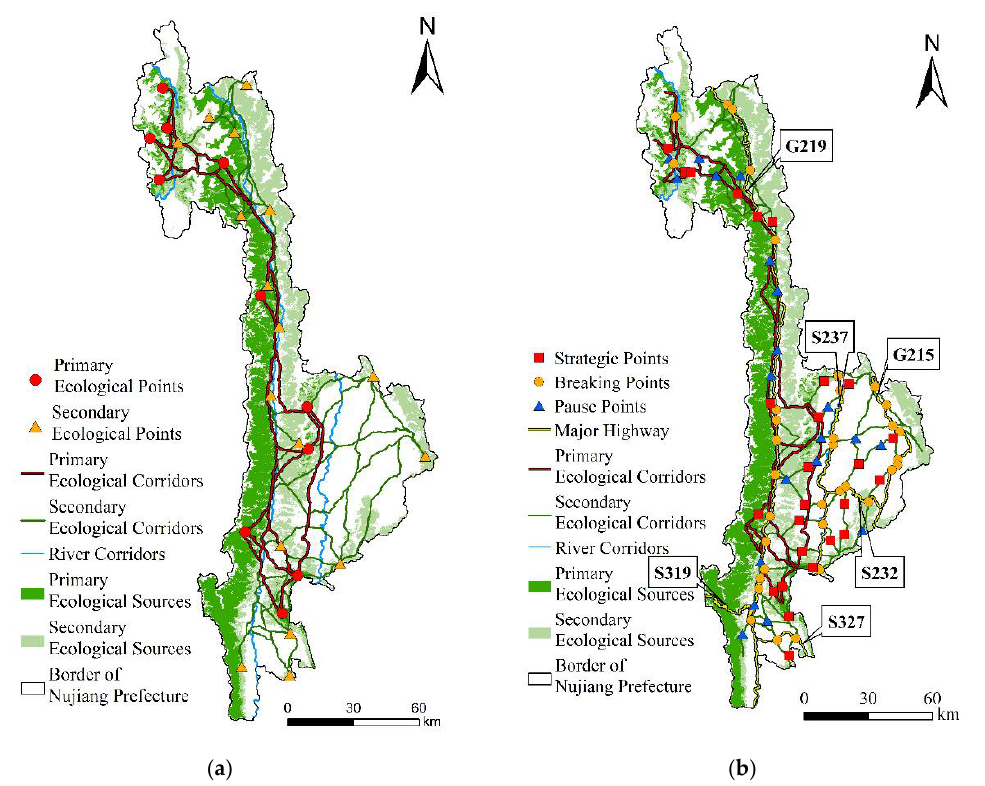
Figure 9. ( a ) Spatial distribution of ecological corridors; ( b ) Spatial distribution of ecological nodes in Nujiang Prefecture.